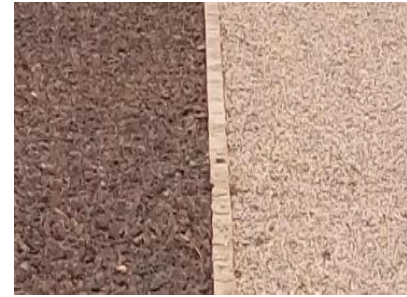
Figure 9. Bifurcation wall separating two materials.